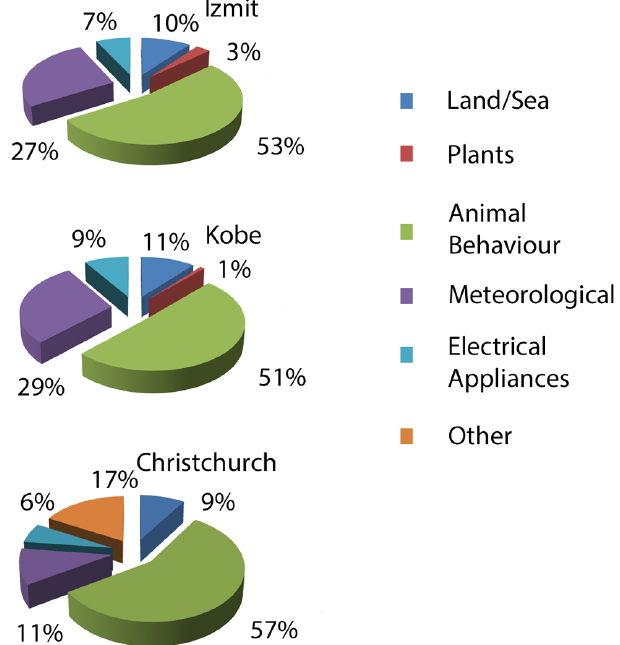
Fig. 2. Various unusual phenomena retrospectively reported through letter, fax, and e-mail by citizens (a) before the ˙Izmit earthquake in 1999 and (b) before the Kobe earthquake in 1995. (Ulusoy and Ikeya, 2008), (c) before the Christchurch earthquake in